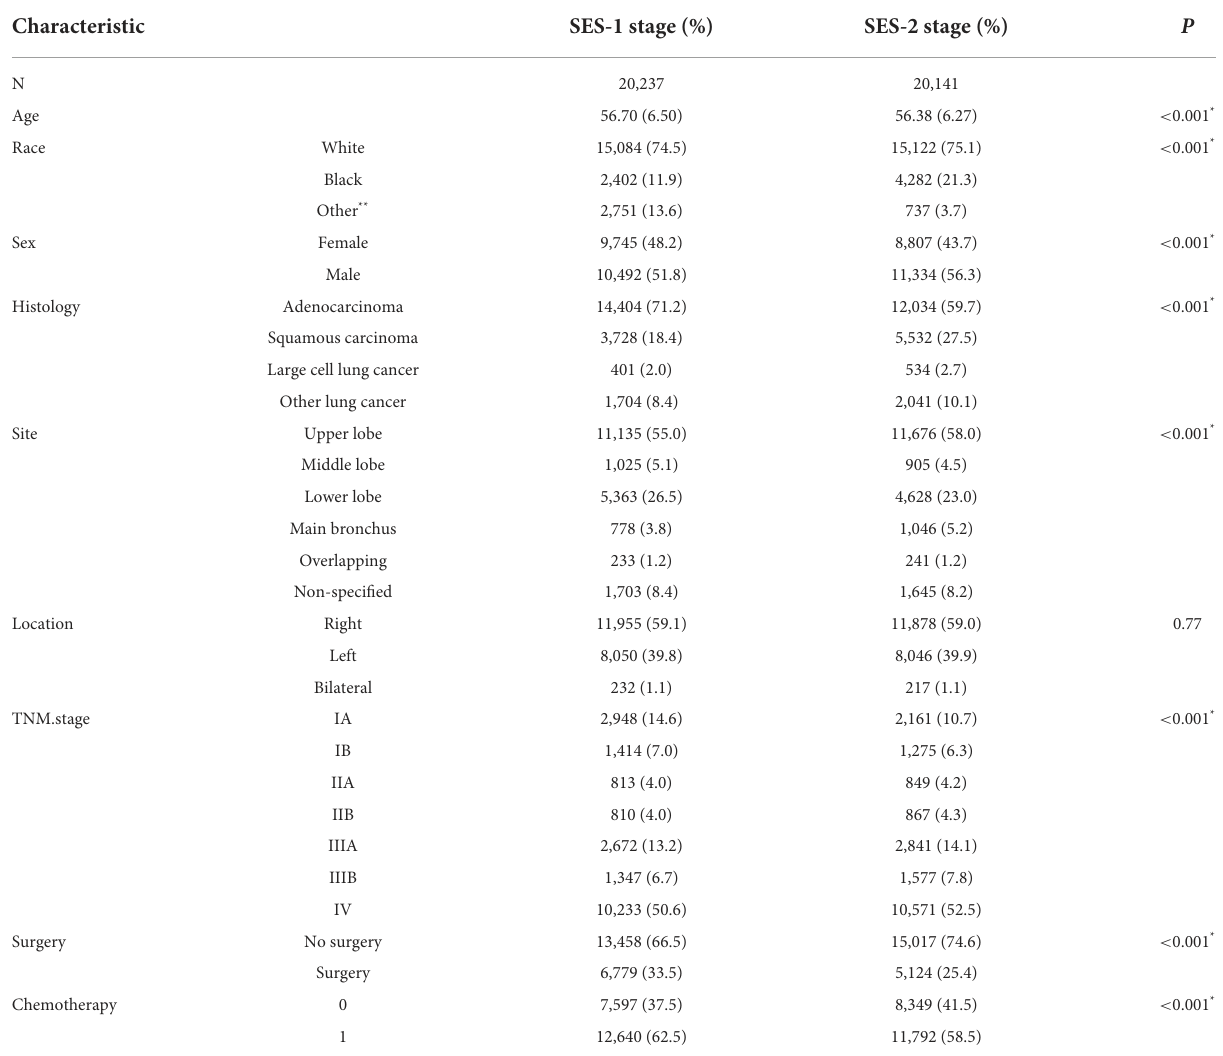
TABLE 3 The characteristics of patients with NSCLC in two SES stage.